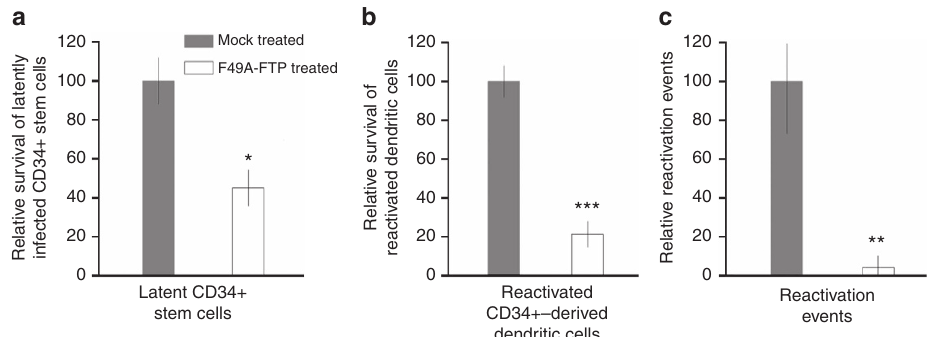
Figure 5 | F49A-FTP kills experimentally latently infected CD34 þ progenitor cells, reducing HCMV reactivation events. CD34 þ progenitor cells were experimentally infected with SV40-GFP-TB40E at an MOI of 5 that led to a mean average of 8.5% of cells latently infected. After 24h, F49A-FTP was added to CD34 þ cell cultures and incubated for 72h. Changes in the number of GFP-positive latent cells were analysed by fluorescence microscopy and compared with a mock-treated control that was set at 100% ( a ). These CD34 þ cells were then differentiated to mature dendritic cells and changes in the percentage of GFP-positive mature dendritic cells were measured ( b ). Finally, the cells shown in b were co-cultured with fibroblasts for 2 weeks and the number of IE foci were counted ( c ). Means and error bars (showing s.d.) were generated from three independent experiments. Statistical analyses were carried out using a paired two-tailed t -test and P values expressed as * P ¼ 0.05, ** P ¼ 0.01 or *** P ¼ 0.001.